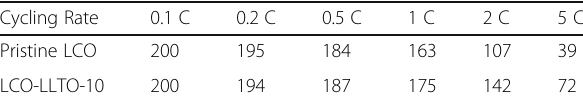
Table 1 The average discharge capacities (mAh/g) of pristine LCO and LCO-LLTO-10 at different cycling